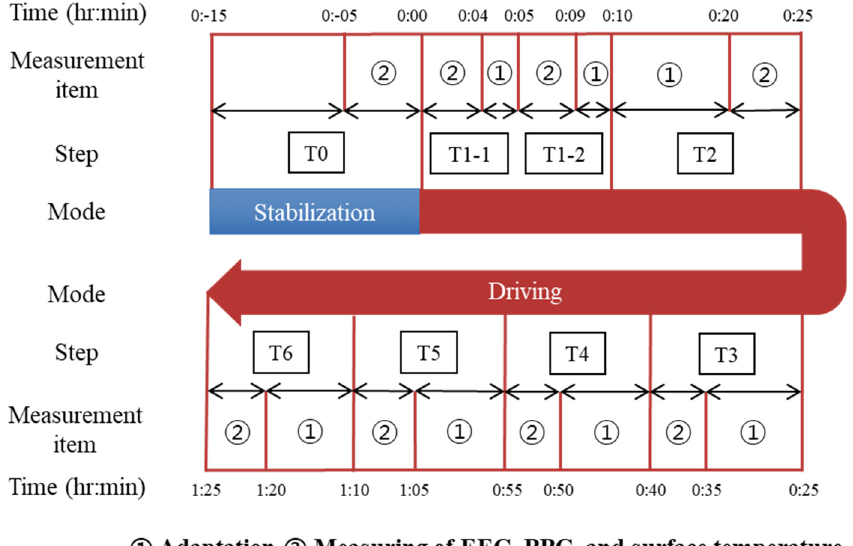
Figure 4. Experimental procedure and measurement items.